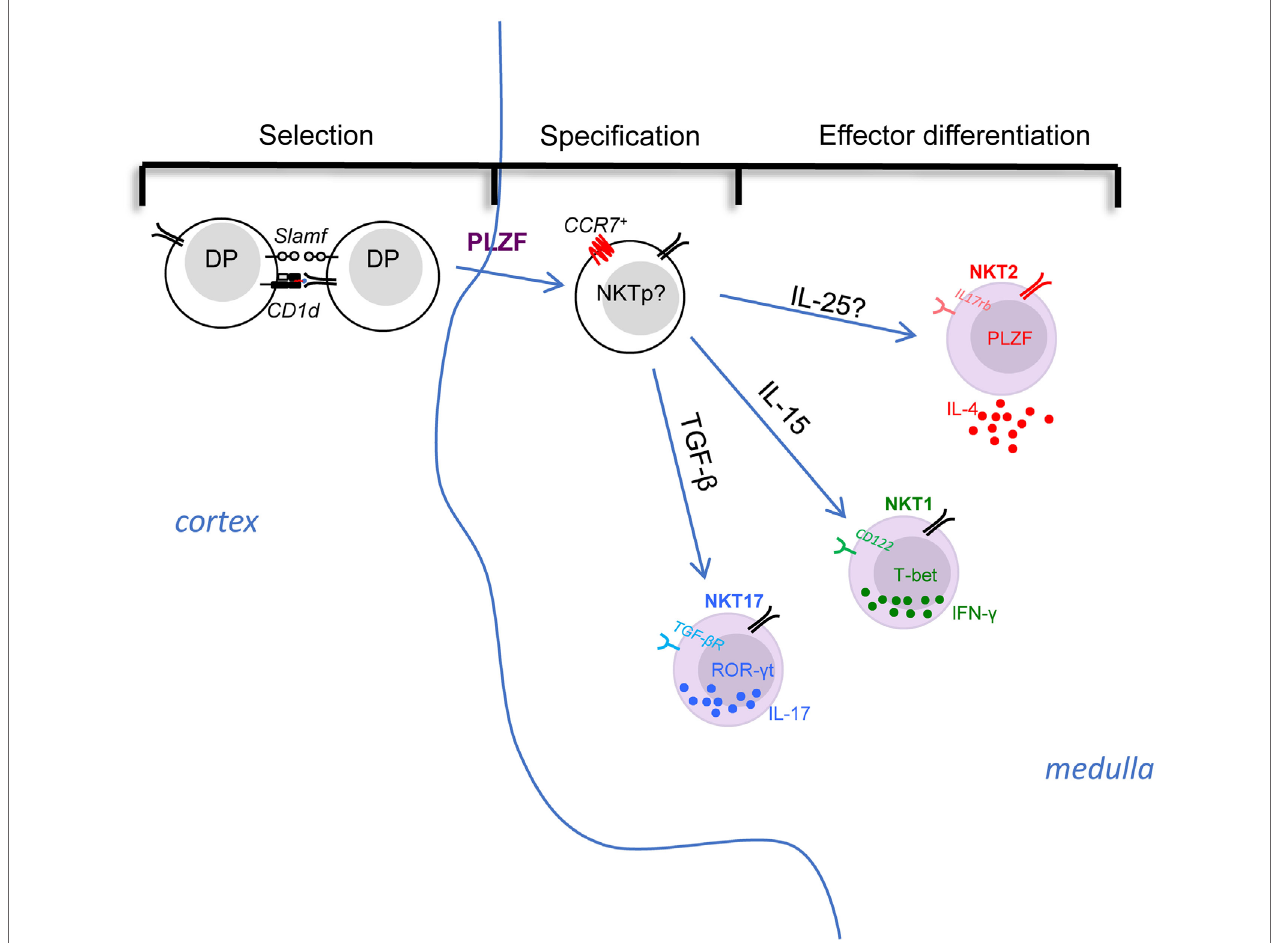
FigURe 1 | The selection, specification, and effector differentiation of invariant natural killer T (iNKT) cells in the thymus. The initial positive selection of iNKT cells depends on the interaction among double-positive thymocytes in cortex. Then, with the upregulation of PLZF and the chemokine receptor CCR7, the multi-potent iNKT common precursors migrate to thymic medulla and specify their fate into different effector subsets. The effector differentiation into NKT1, NKT2, and NKT17 are influenced and directed by various factors. For instance, cytokine signals play essential roles in differentiation: IL-15 is critical for CD122 expressing NKT1 cell differentiation, whereas TGF- β is required for TGF- β R-expressing NKT17 cells, while NKT2 cells express IL-17 RB (IL-25 receptor), although the role of IL-25 requires evaluation. iNKT subsets are poised in an effector state, but only NKT2 cells are actively producing cytokine (IL-4) at steady state, while NKT1 and NKT17 cells maintain potential to produce IFN- γ or IL-17, respectively, after